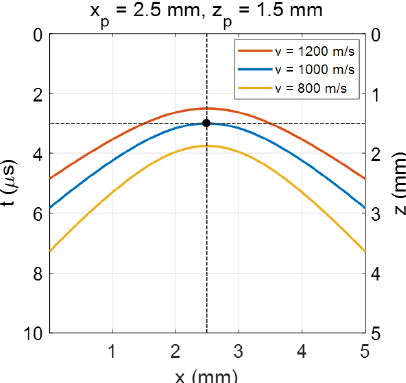
Figure 2. The hyperbolic curves simulated with the same target position but with different acoustic velocities. The minimum time delay and the slope of curve were changed with the velocity variation.